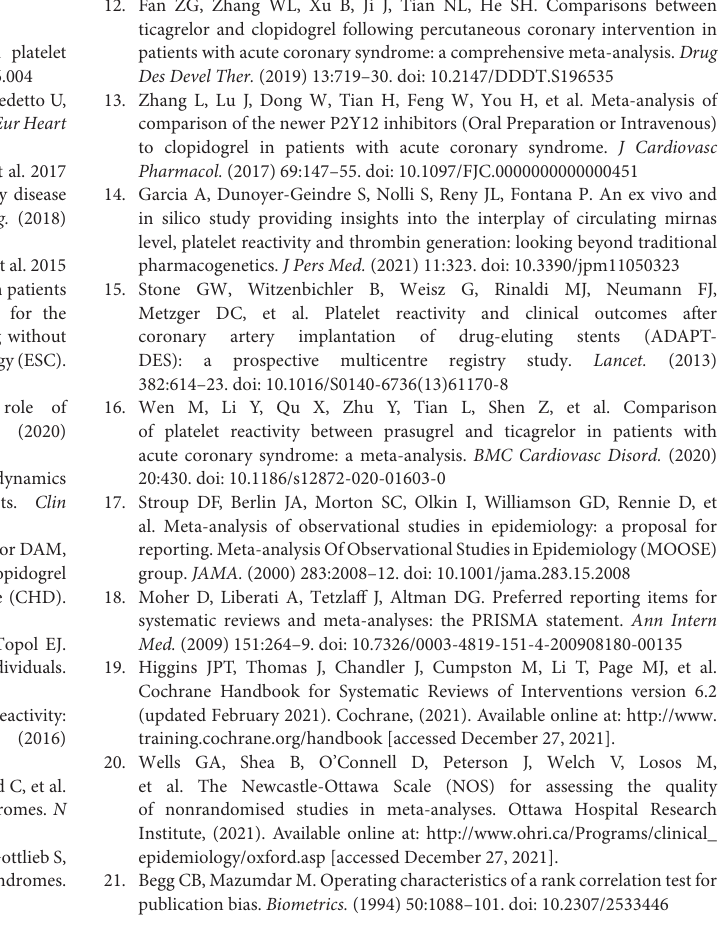
Supplementary Figure 1 | Forest plots of meta-analysis results of clinical outcomes. Supplementary Figure 2 | Sensitivity analysis for PRU-LD 2-6h, PRI-LD 6-18h, PRU-MTD, PRI-MTD, HTPR-PRI-LD 6-18h, LTPR-AUC-MTD, TIMI Minor or Minimal Bleeding, and Bleeding BARC type 1. Supplementary Figure 3 | Funnel plot of comparison of PRU after MTD between ticagrelor group and prasugrel group. Supplementary Table 1 | Embase search strategy. Supplementary Table 2 | Web of science search strategy. Supplementary Table 3 | Cochrane search